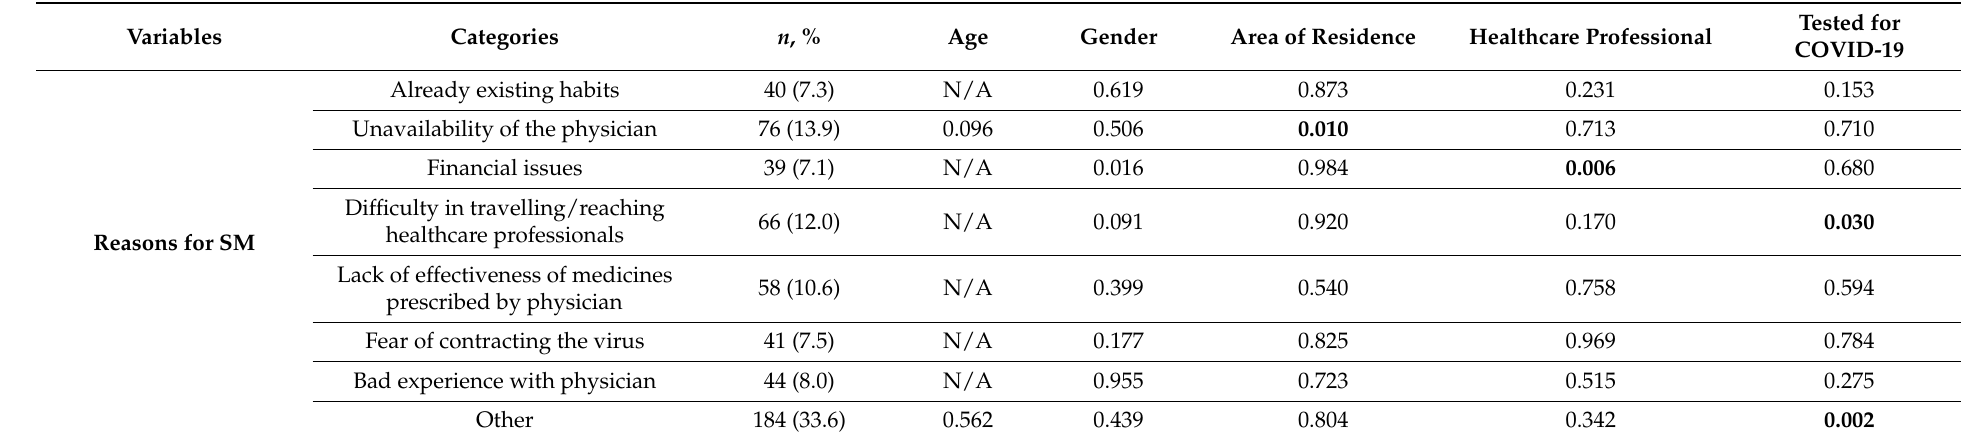
Table 4. Contributing factors and reasons associated with SM during the COVID-19